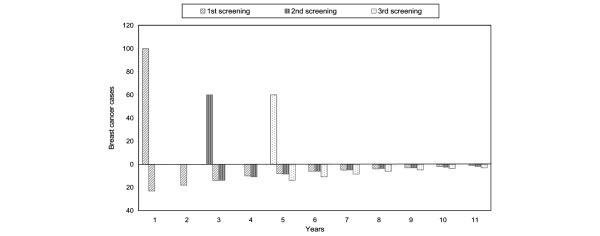
Incremental and decremental cases in a cohort of women aged 64 years at entry.